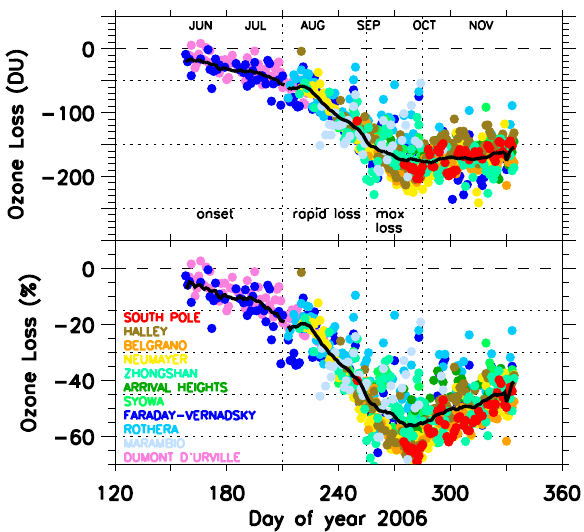
Fig. 2. Chemical O 3 loss estimated from observations at 11 ground- based stations inside the vortex in the winter 2006. The O 3 loss is estimated as the measured O 3 minus the modelled passive O 3 tracer, which is initialised on first of June. The average loss estimated from the observations is shown as a solid line. The dotted lines represent − 50, − 150, and − 250DU and − 15, − 30, − 45 and − 60% of O loss. The vertical lines represent days 210, 255 and